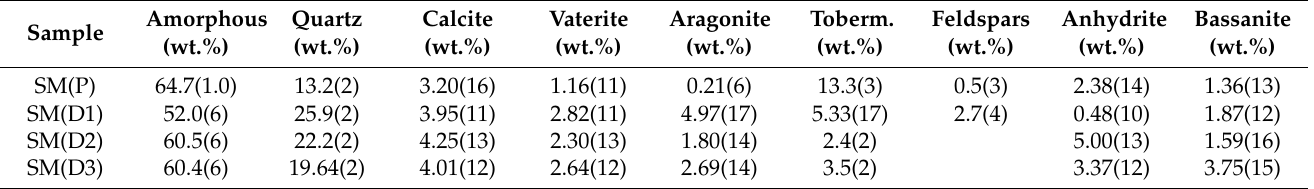
Table 2. Quantitative phase contents determined by XRD analysis of the raw materials. The e.s.d.’s. are shown in parentheses (Toberm. = 11 Å tobermorite).